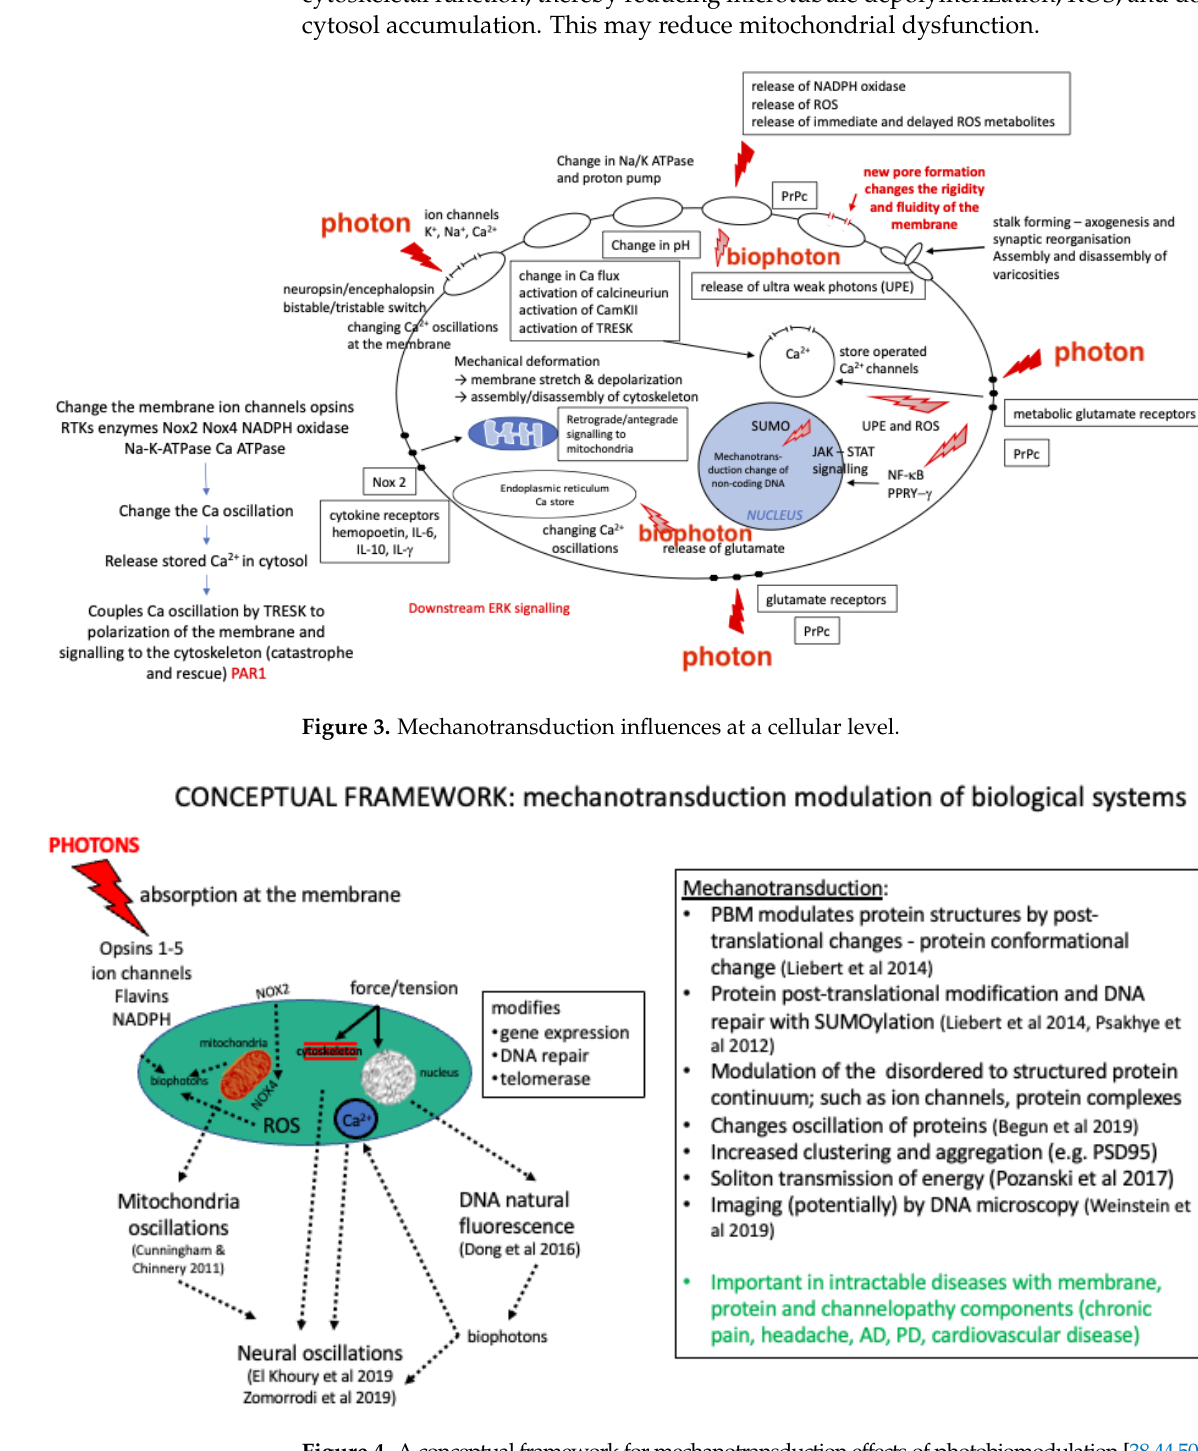
Figure 4. A conceptual framework for mechanotransduction effects of photobiomodulation